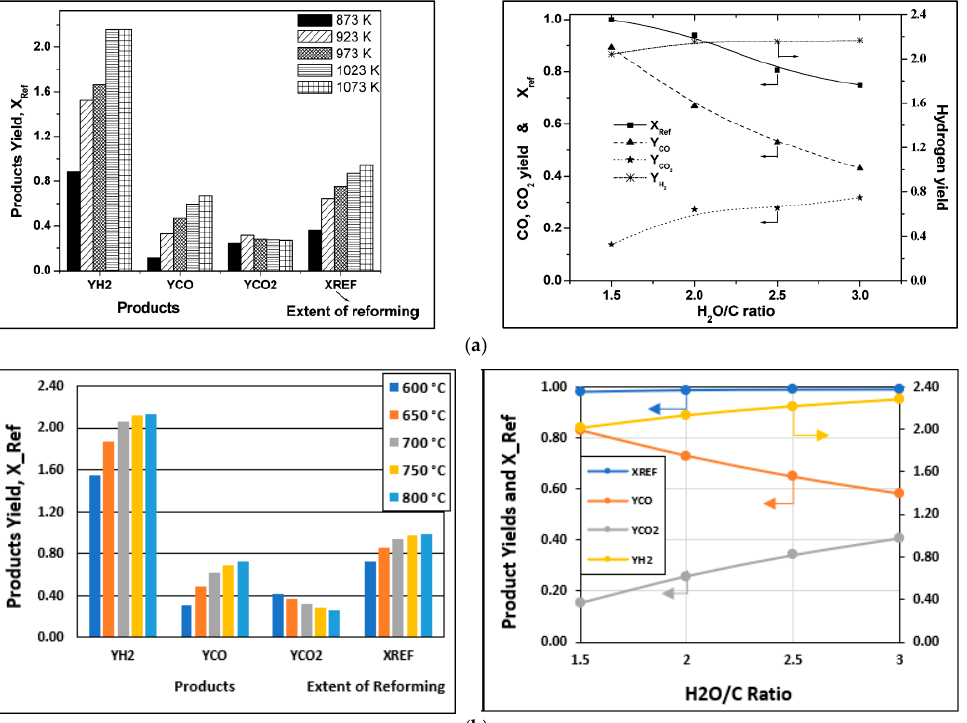
Figure 3. ( a ) n-dodecane experimental reforming results [25]. ( b ) Thermodynamic calculation based on a Gibbs reactor.